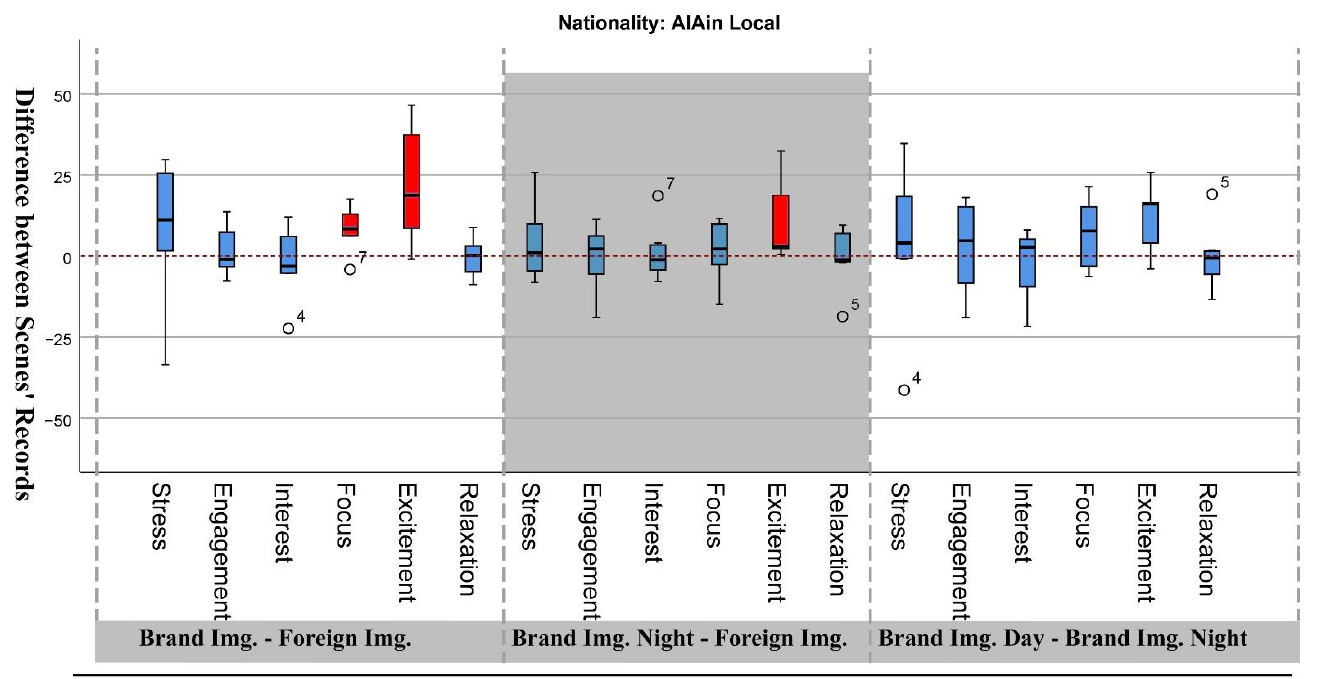
Figure 2. Wilcoxon analysis of EEG data from Al Ain locals.